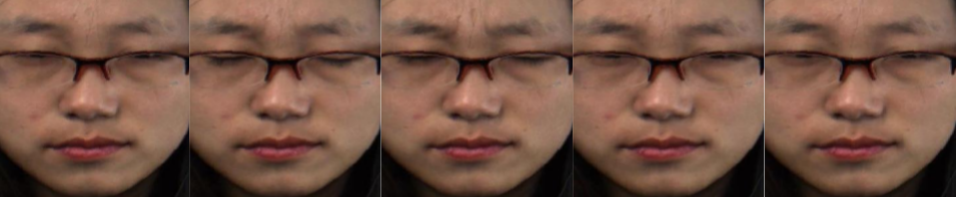
Figure 2. Sample frames showing Subject 26’s micro-expression clip ‘EP18_50’ that was coded as an AU4 in the ‘disgust’ category ( c (cid:13) Xiaolan